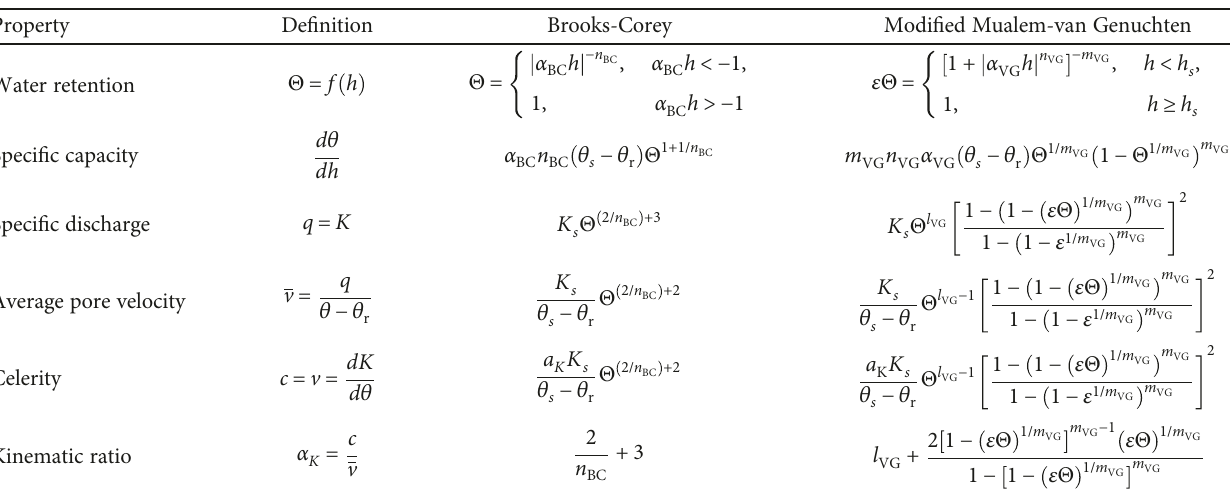
Table 1: Constitutive relationships under the unit hydraulic gradient condition formulated by the Brooks-Corey model and the modi fi ed Mualem-van Genuchten model.